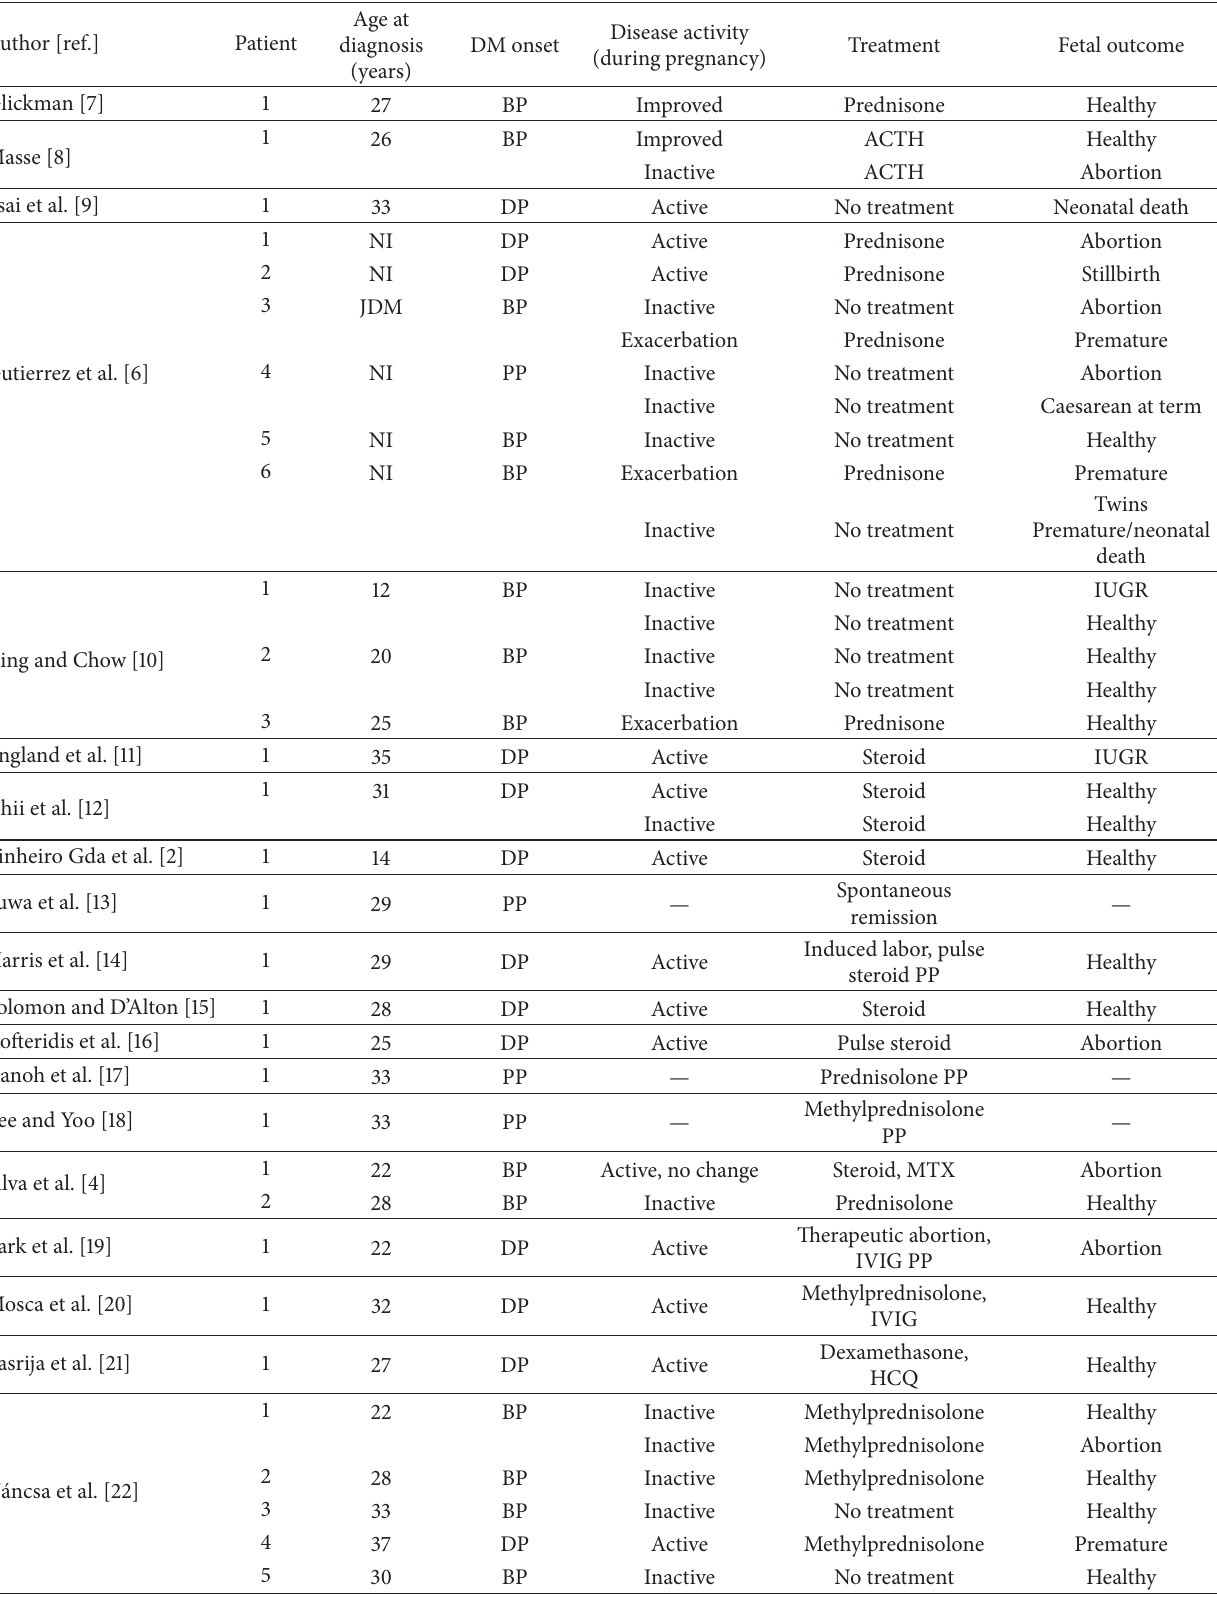
Table 1: Dermatomyositis complicating pregnancy. Review of the